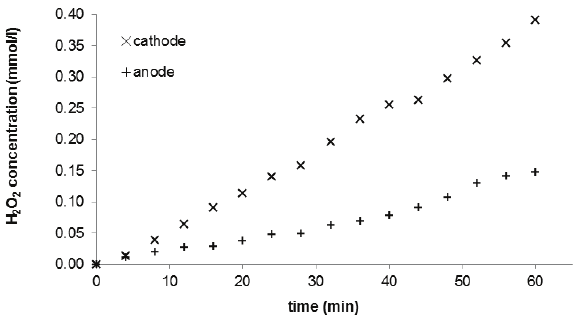
Figure 2 : Typical time dependency of hydrogen peroxide concentration, graphite electrodes.